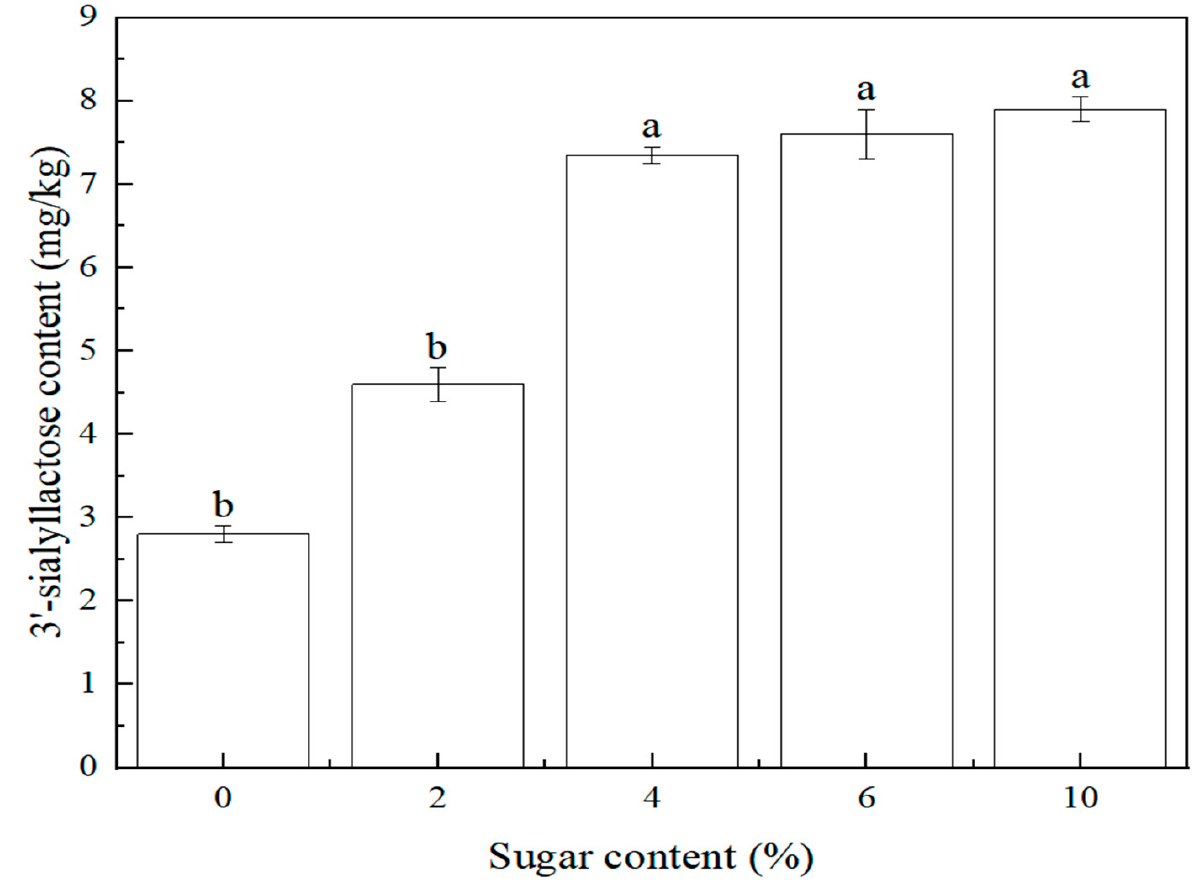
Figure 7. Relationship between 3’-sialyllactose content and sugar content ( n = 2, p < 0.05).